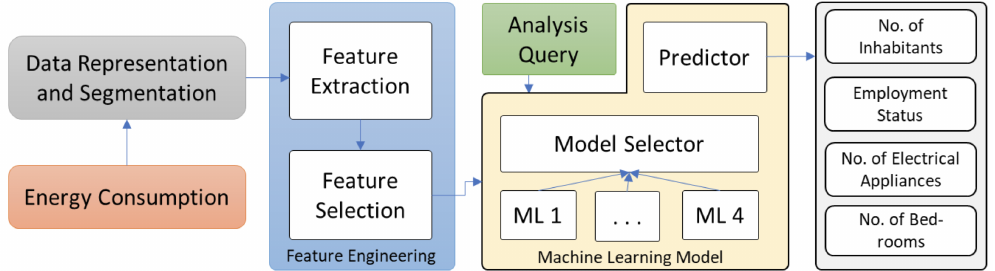
Figure 1. The proposed architecture for analyzing the energy profiles. The energy consumption flows from smart meters to data representation and segmentation block, where continuous data is chunked. Later, we extracted the features and passed the selected features to a machine learning model for learning the household characteristics. Based on the query, the learned model will predict the household